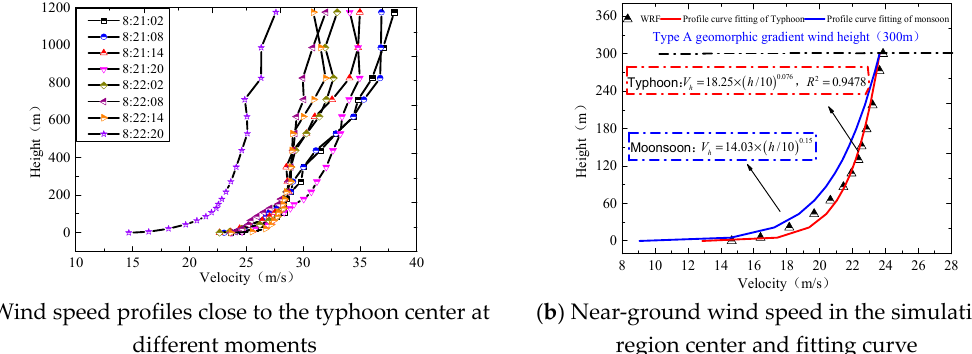
Figure 9. Wind speed profiles close to the typhoon center at different moments and near-ground wind speed and fitting curves in the simulation center.